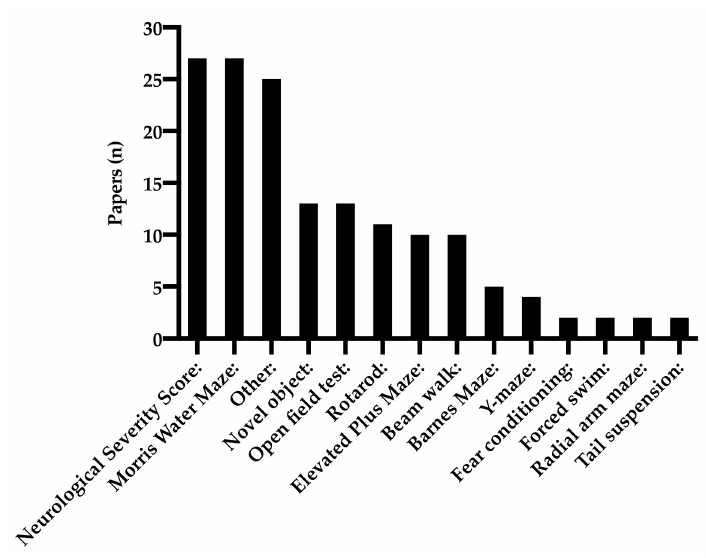
Figure 4. Behavioral tests analyzed in the reviewed